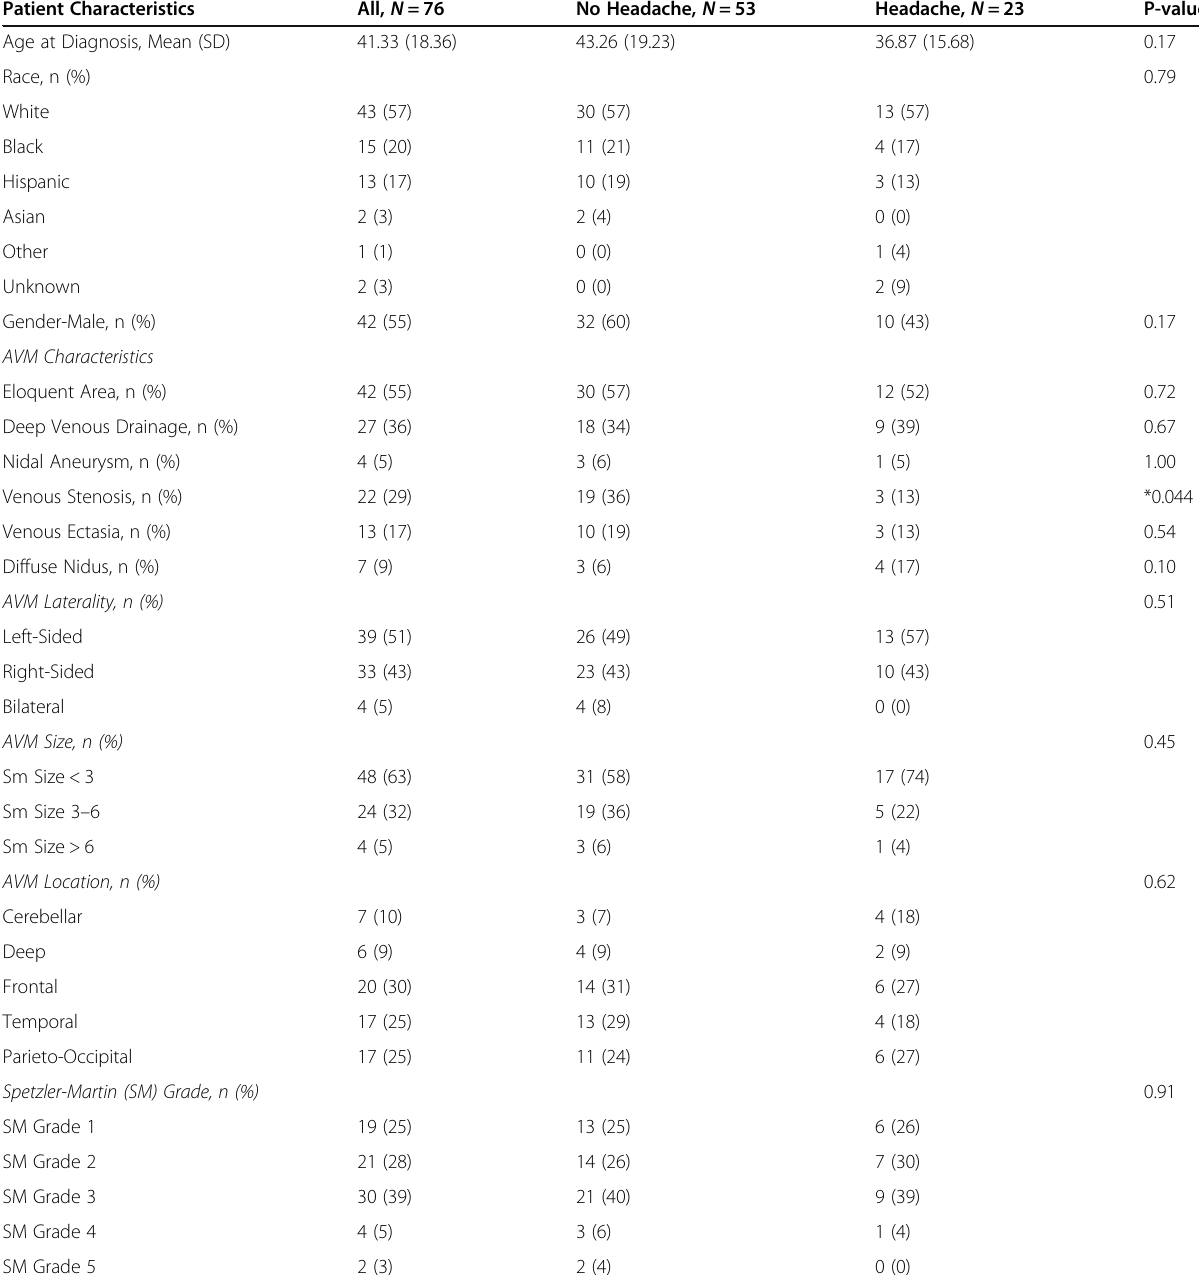
Table 1 Unruptured AVM patient demographics and clinical characteristics. * = significant correlation Patient